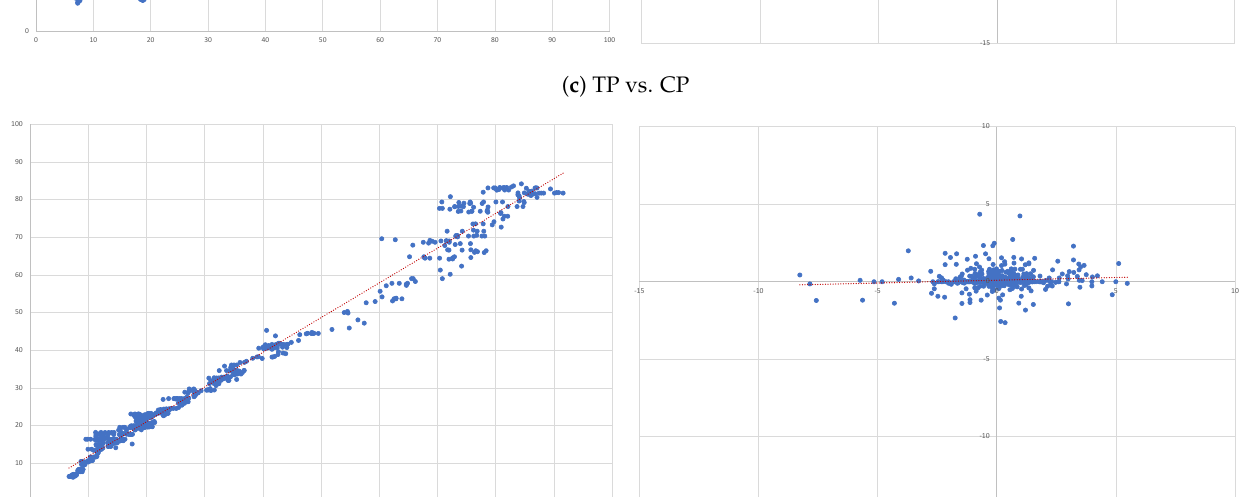
Figure A5. Fresenius. Individual time series regressions using three price series on Fresenius: future prices (FP), target prices (TP), and capitalised prices (CP) forecasts. On the left-hand-side are images of level regressions and on the right-hand-side are regressions in